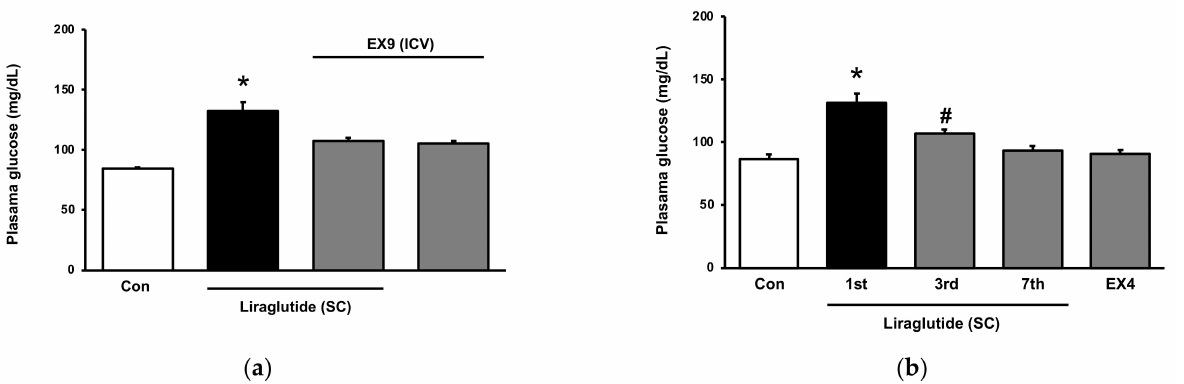
Figure 3. Cross-tolerance of hyperglycemia between liraglutide and Exendin-4 (Ex-4) in normal rats. ( a ) Hyperglycemia by peripheral injection of liraglutide (SC) was blocked by EX-9 in the brain (ICV); ( b ) Tolerance of hyperglycemia by liraglutide observed in normal rats received a repeated daily injection for one week. Another agonist of GLP-1R Ex-4 also failed to induce hyperglycemia in normal rats with tolerance to liraglutide. The data are shown as means ± SEM ( n = 8). * p < 0.05 vs. normal control group; # p < 0.05 vs. first